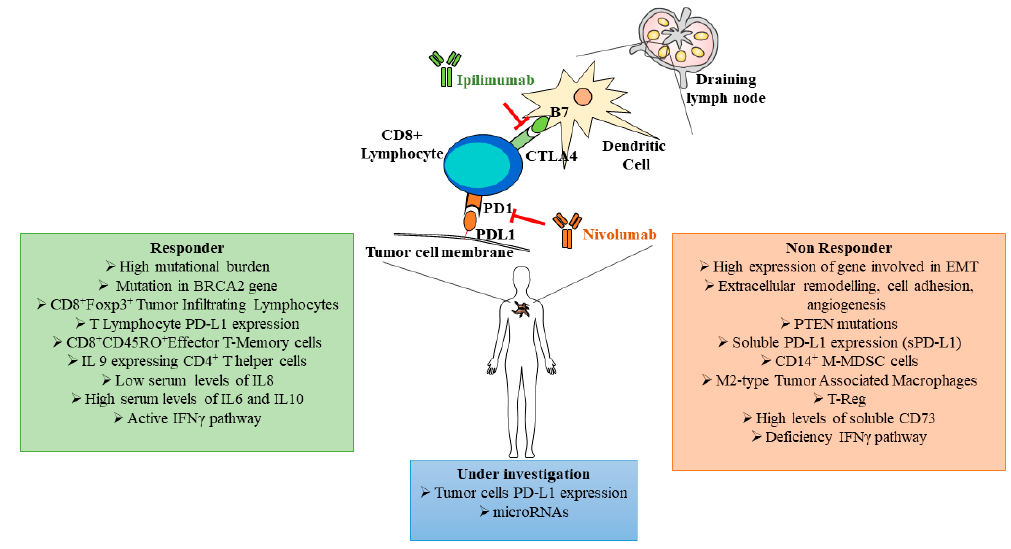
Figure 2. Schematic representation of some key immune checkpoint blocker functional links and predictive biomarkers associated to responder (green box) and non-responder (red box) patients. In the blue box are indicated melanoma biomarkers still under investigation. PD-L1: programed cell death ligand 1, PD-1: programed cell death 1, sPD-L1: soluble programed cell death ligand 1, CTLA4: cytotoxic T-lymphocyte associated protein 4, BRCA2: breast cancer type 2 susceptibility protein, Foxp3: forkhead box p3, IL: interleukin, IFN: interferon, EMT: epithelial–mesenchymal transition, PTEN: phosphatase and tensin homolog, MDSC: myeloid derived suppressor cells, M-MDSC: monocyte myeloid derived suppressor cells; T-Reg: regulatory T cells.